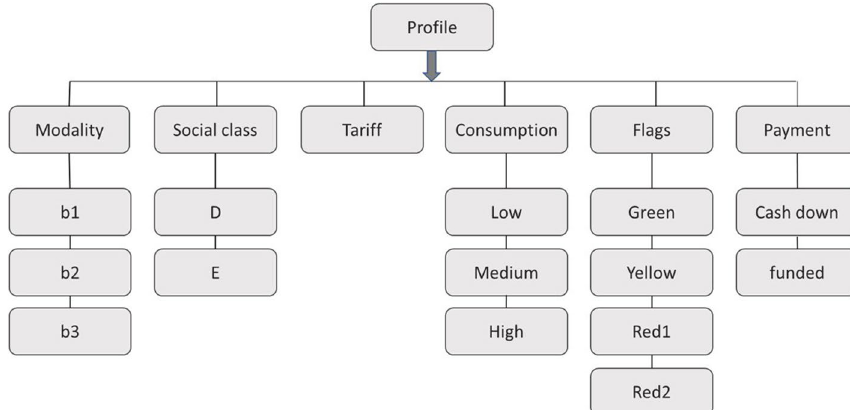
Fig. 7 Inputs used in the knowledge-based